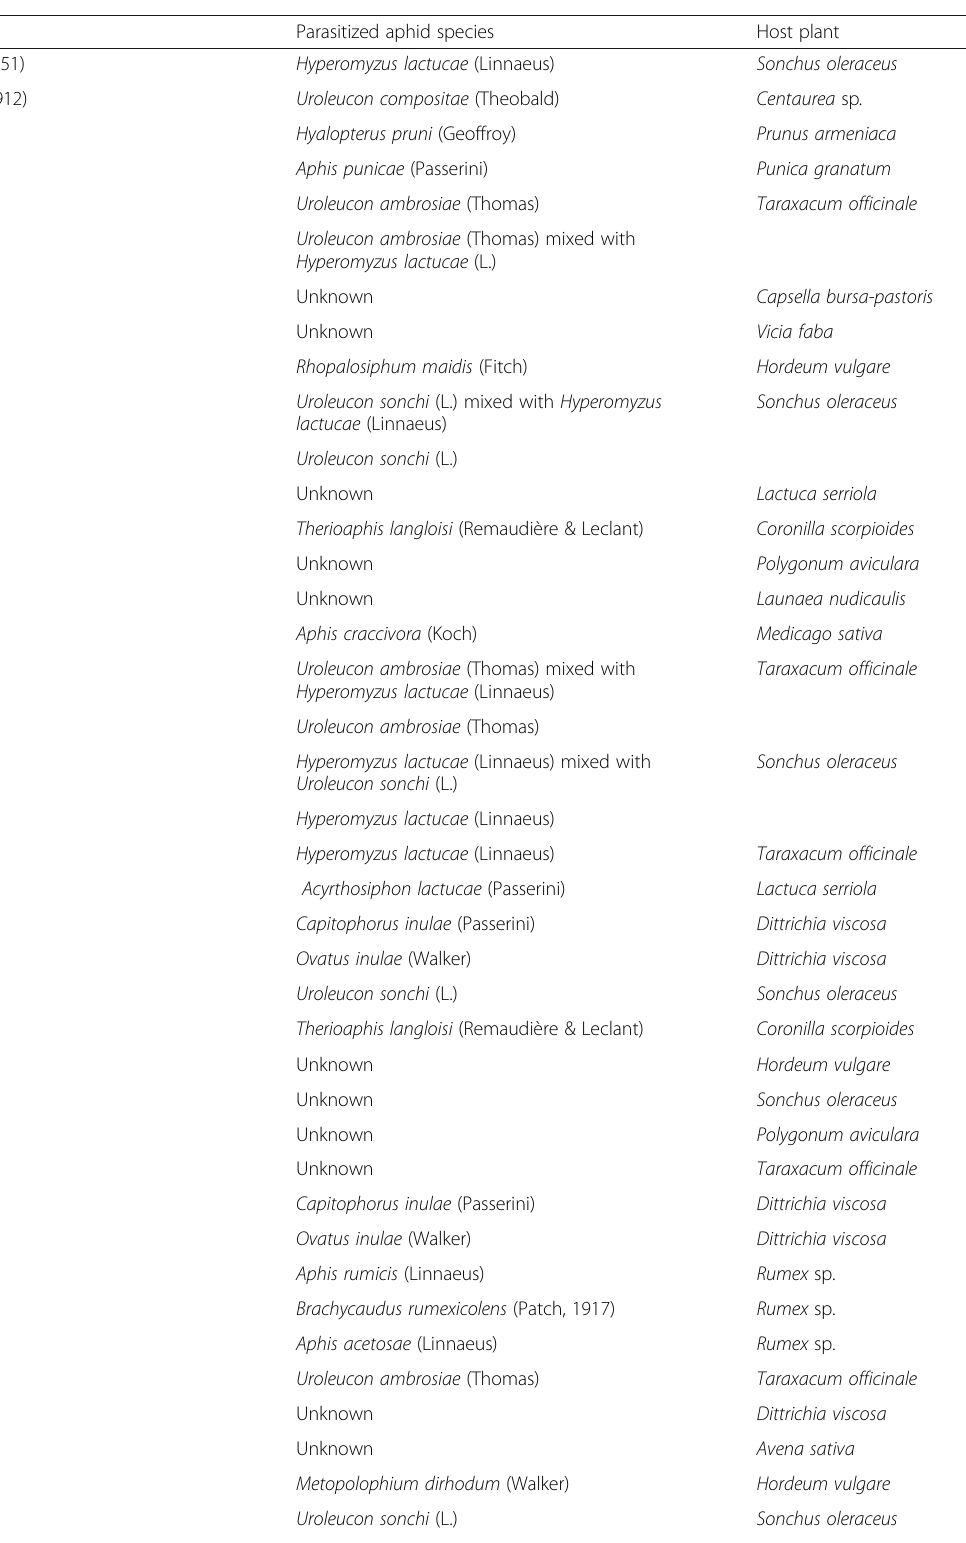
Table 1 Tri-trophic associations, plant-aphid-parasitoid, noted at the oasis ecosystems in the region of Biskra between 2014 and 2016